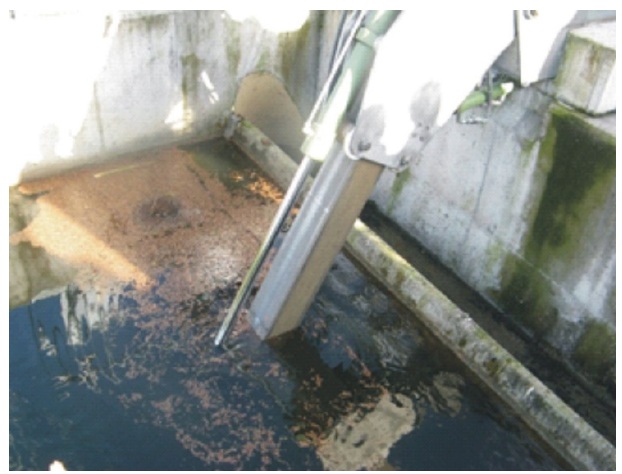
Figure 1. Purification of water from “thick” pollution at an SHP (photography: B. Igli ń ski).